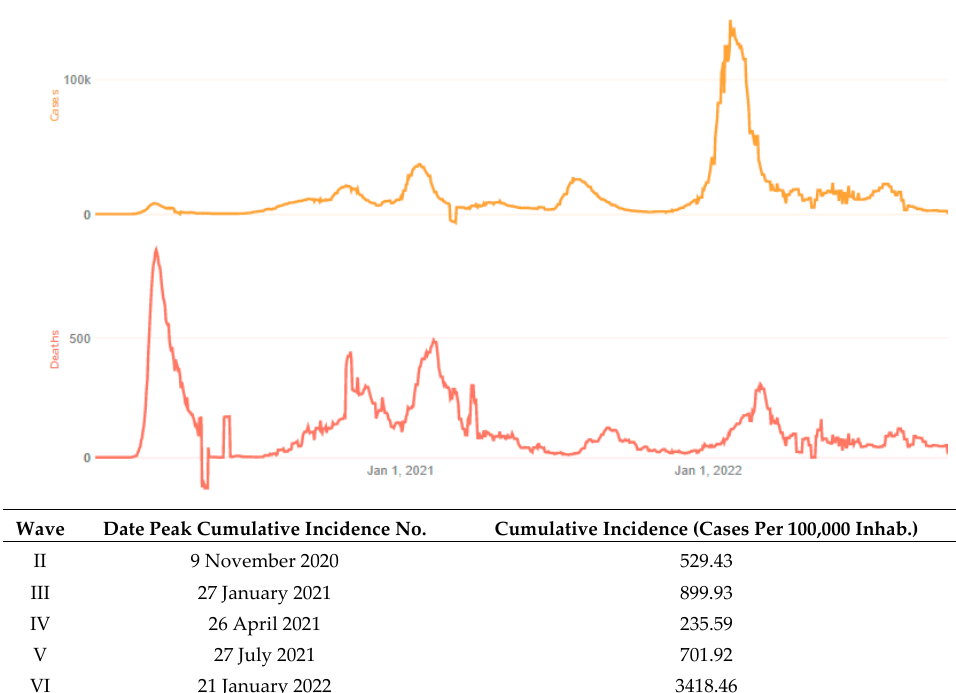
Figure 1. On the top: cases and death data that were adapted from JHU CSSE; testing and vaccine data from JHU CCI; hospitalization data from the U.S. Department of Health and Human Services. On the bottom: cumulative peak incidence across COVID-19 waves in Spain. Author’s own elaboration based on data that were obtained from the Red Nacional de Vigilancia Epidemiológica (RENAVE).